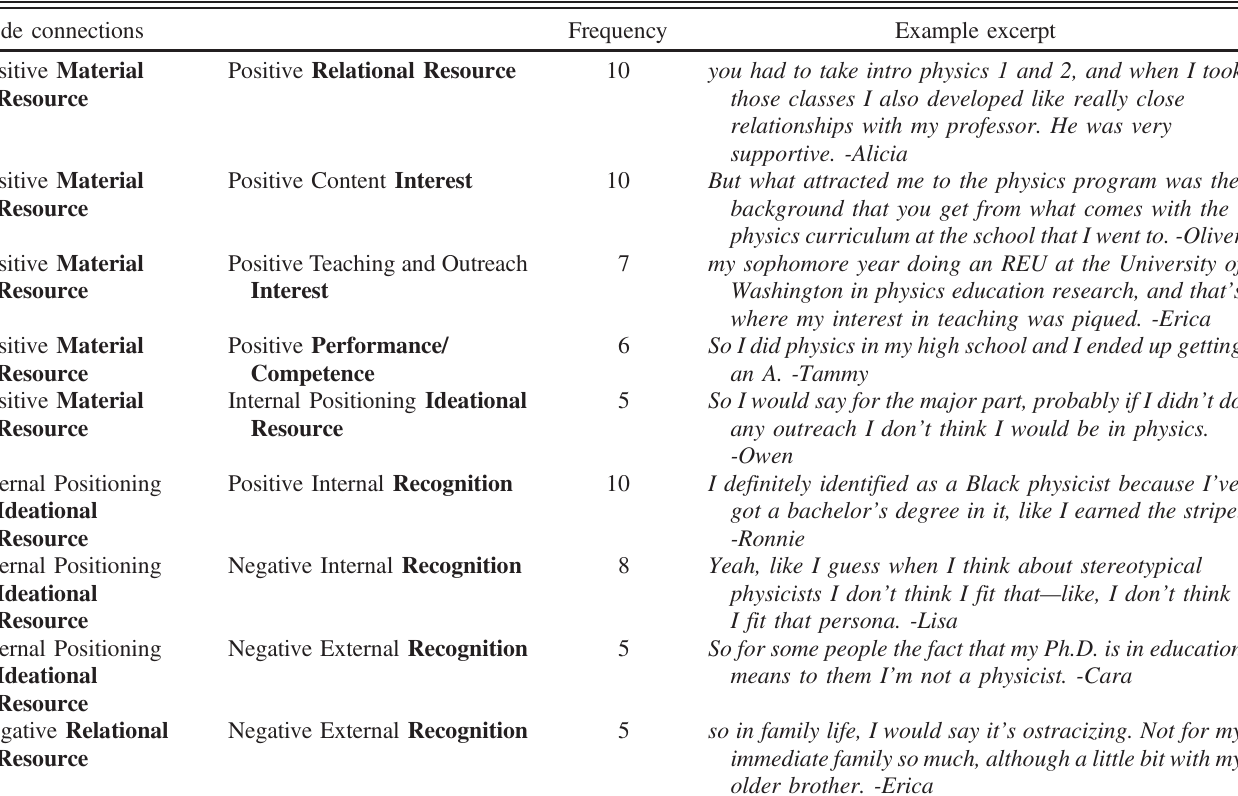
TABLE I. List of code connections from our sample that co-occurred 5 or more times across the 11 interviews. Each connection includes the names of subcodes that were coded together, the number of times they were coded together, and an example excerpt from an interview where this code connection occurs. The table is organized with the most coded constructs listed first and color-coded by construct (positive constructs have a lighter shade, and negative with bolder shade). We note that this organization does not imply directionality of the